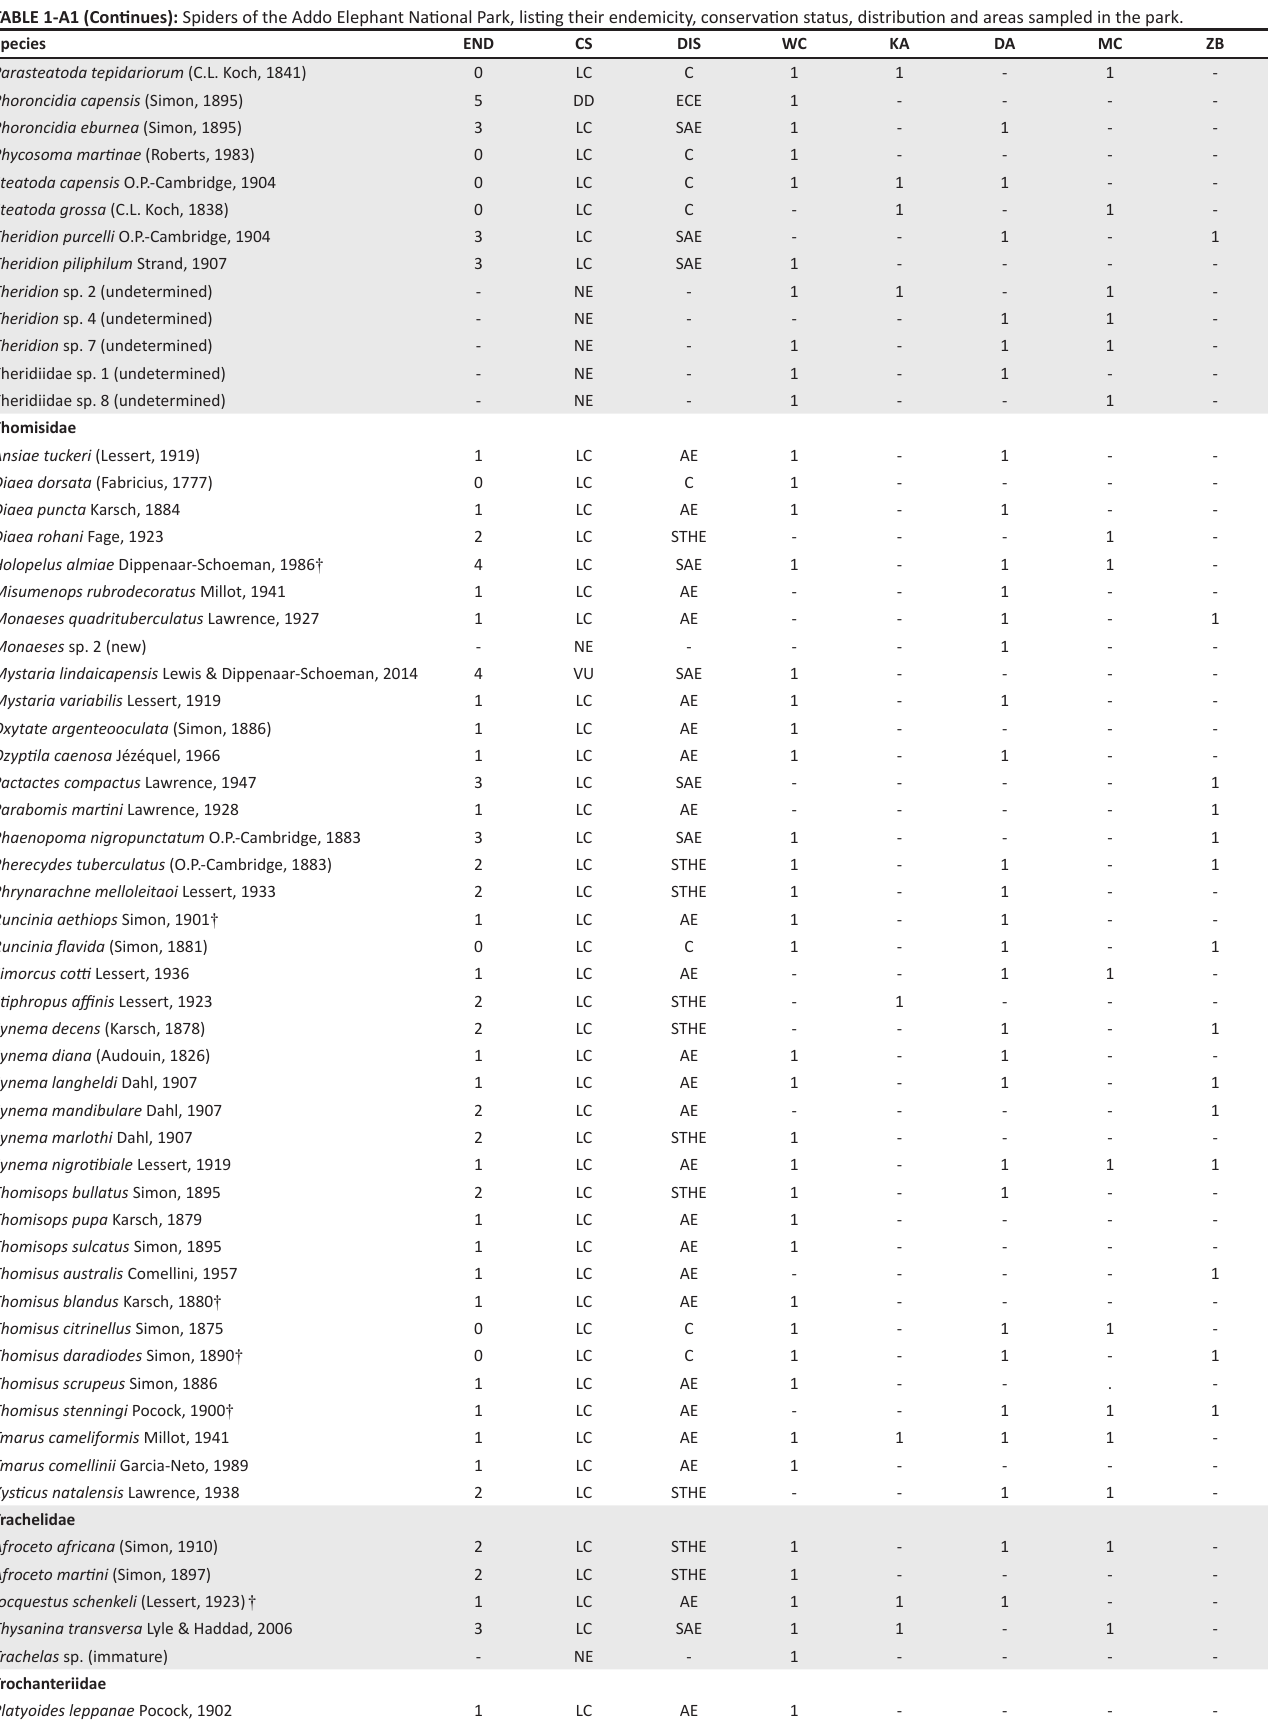
TABLE 1-A1 (Continues): Spiders of the Addo Elephant National Park, listing their endemicity, conservation status, distribution and areas sampled in the park.